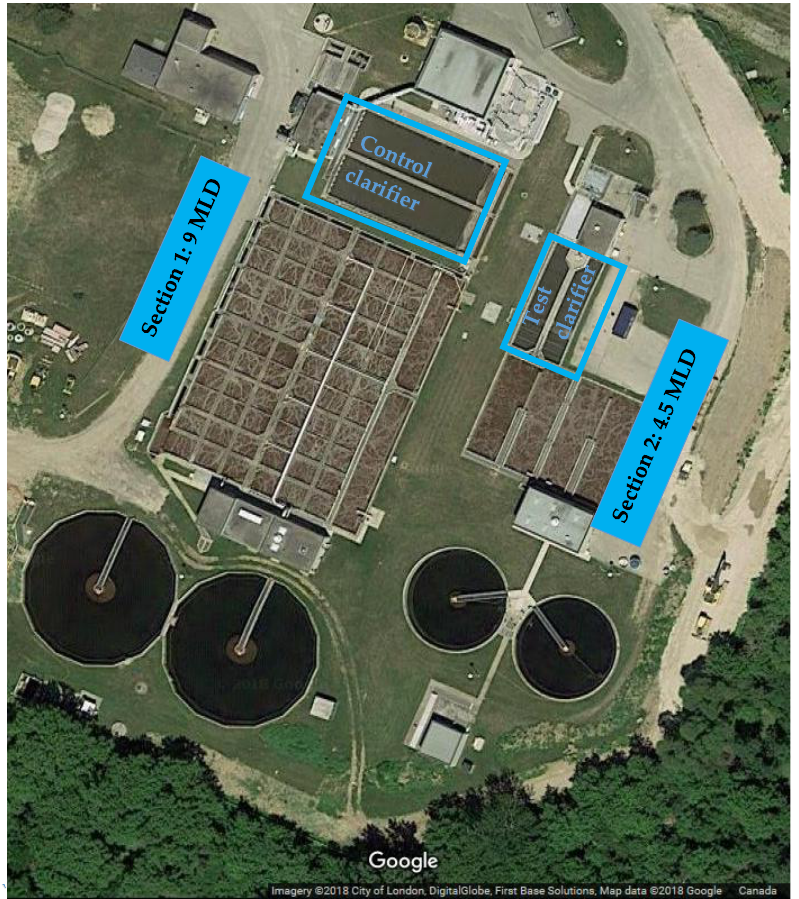
Figure 1. Layout of the Vauxhall Pollution Control Plant (PCP).